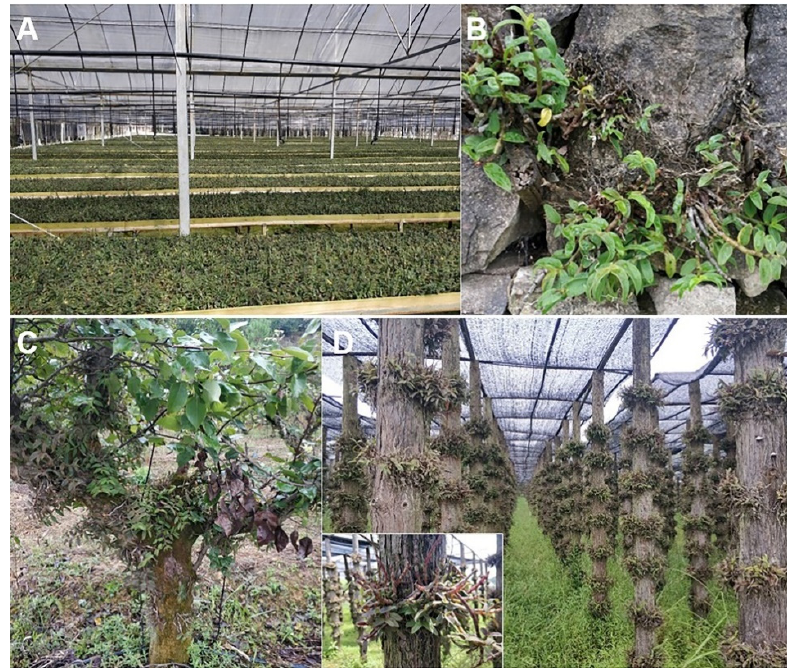
Figure 1. Epiphytic cultivation model of D. catenatum . ( A ). Facility-aided cultivation; ( B ) Rock-dependent eco-cultivation; ( C ) Trunk-dependent eco-cultivation; ( D ) Stereo cultivation.